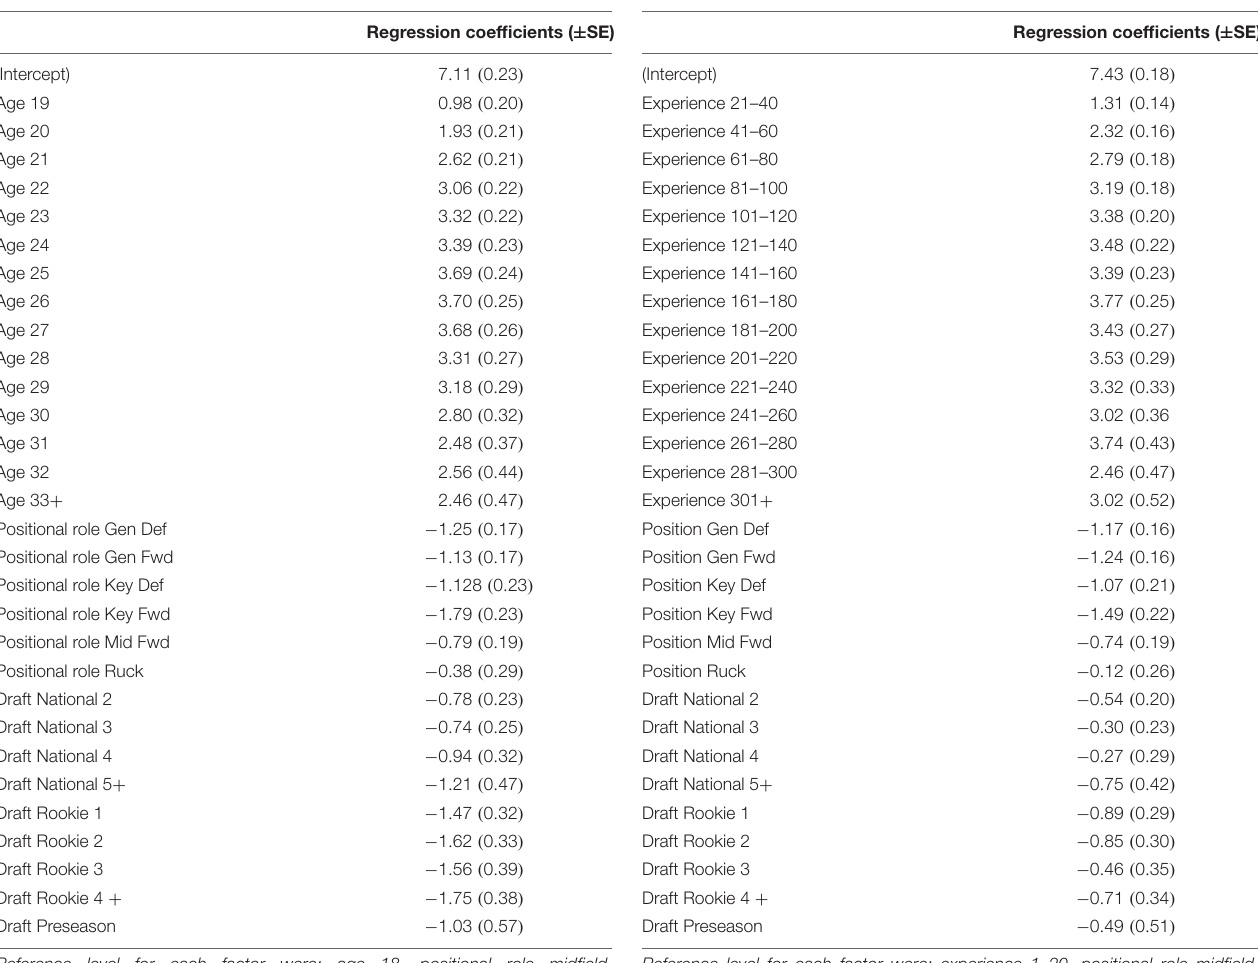
TABLE 2 | Model (2) fixed effect regression coefficients, outlining the estimated difference in rating points from the reference level of each